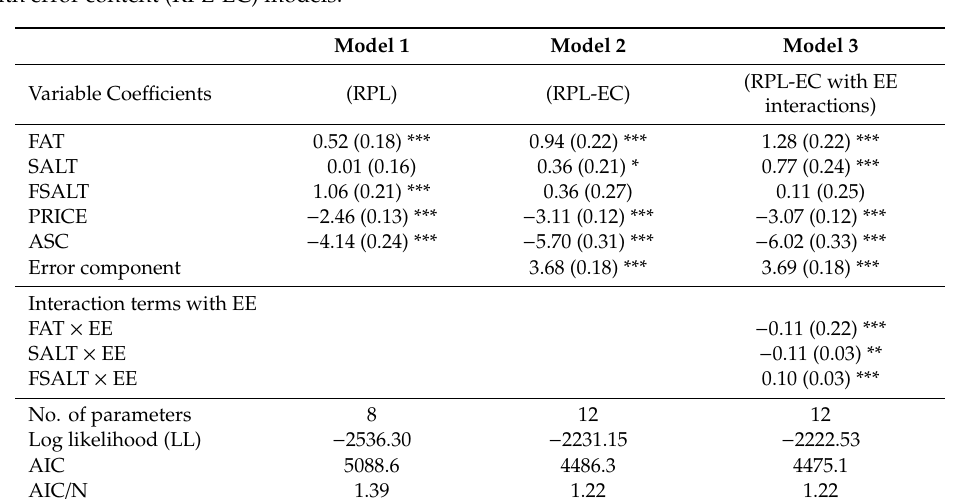
Table 3. Parameter estimates from the parameter logit model (RPL) and the parameter logit model with error content (RPL-EC)